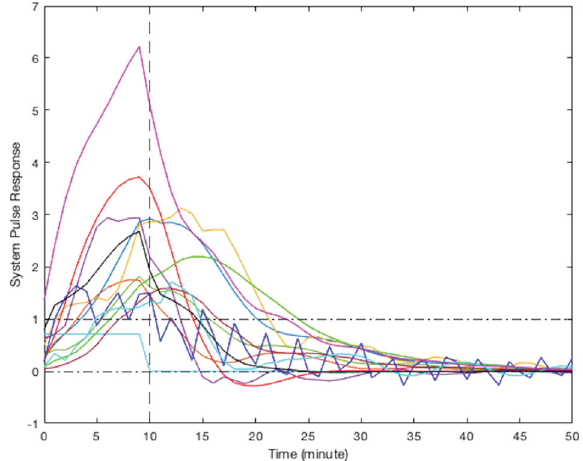
Fig. 8 Pulse response for participants in cluster 4, just one delayed increase in smoking odds in response to stress. The vertical line at the 10-min mark on the x -axis re fl ects the time when the stress probability returned to zero.